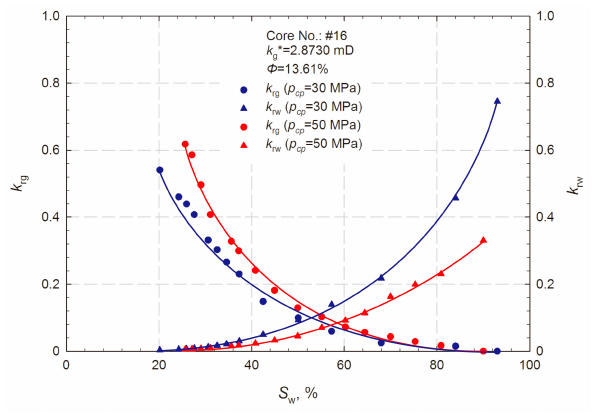
Figure 9. Effect of confining pressure on gas–water relative permeability.